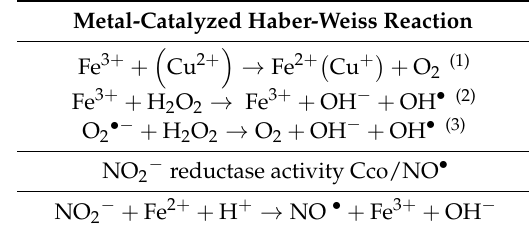
Table 1. Main equations involved in free radical